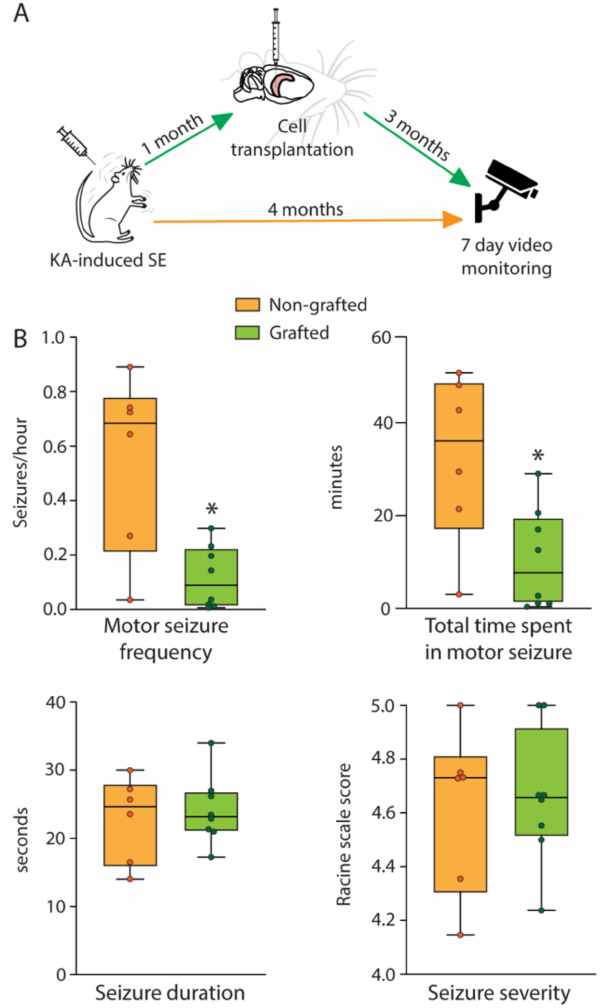
Figure 10. Effect of hdInt grafts on SRSs four months post SE. ( A ) Timeline of the experiments. (( B ) upper panels) Graphs demonstrating median motor SRS frequency and total time in motor SRSs in control epileptic animals (non-grafted) and epileptic animals grafted with hdInts. (( B ) lower panels) Graphs demonstrating median motor SRS duration and motor SRS severity in control epileptic animals (non-grafted) and epileptic animals grafted with hdInts. Note that motor SRS frequency and total time spent in motor SRS were significantly lower in the hdInt grafted group. *, p < 0.05. A Mann-Whitney test was used for comparison of medians in ( B